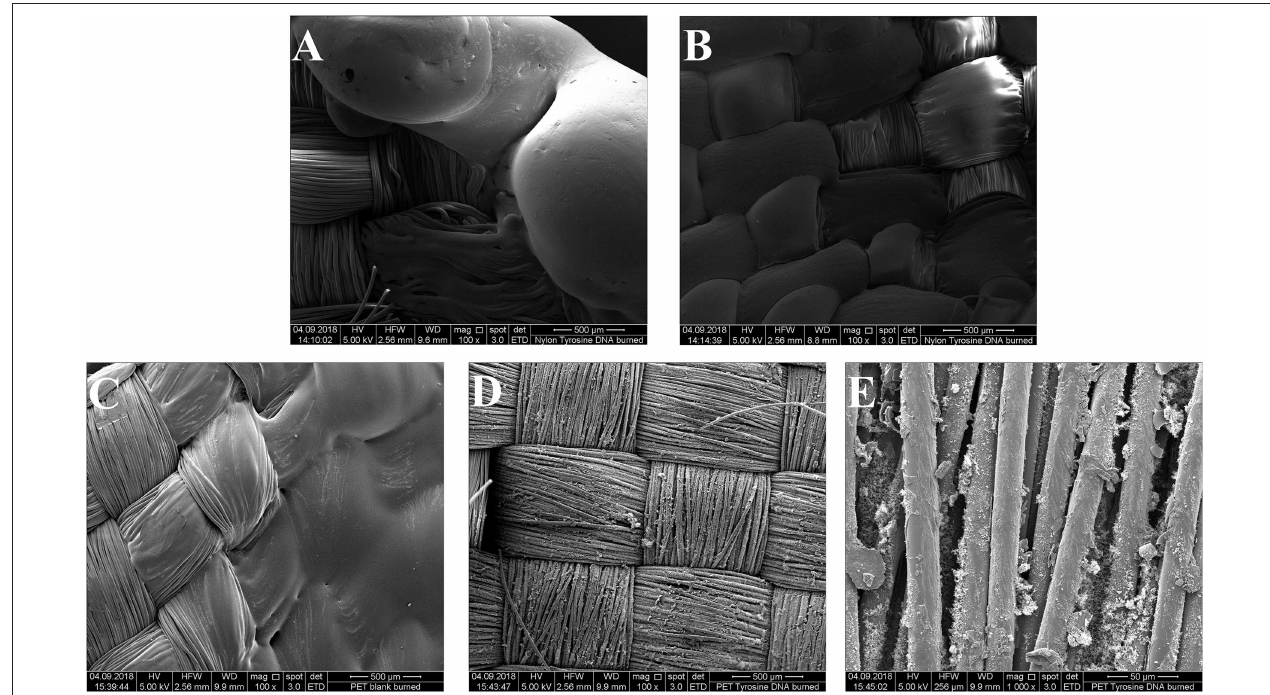
FIGURE 9 | ESEM image of Nylon/Blank burned (100x) (A) and Nylon/tyrosine/DNA burned (100x) (B) in the upper part and PET/Blank burned (100x) (C) , PET/tyrosine/DNA burned (100x), (D) and PET/tyrosine/DNA burned (1000x) (E) .